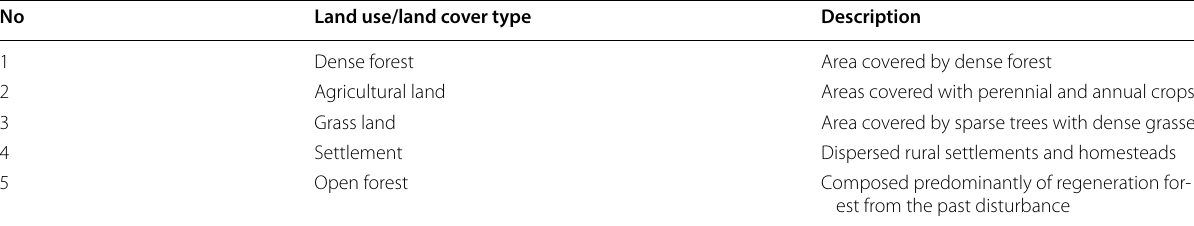
Table 3 Land use and land cover classes